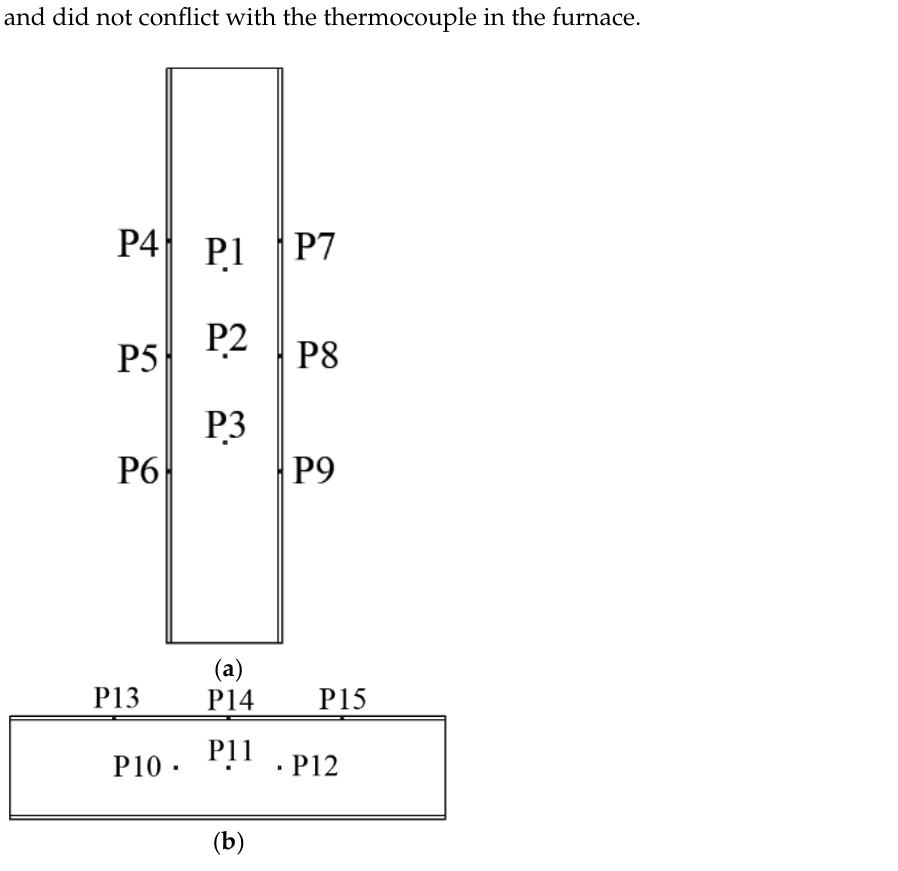
Figure 8. Temperature measuring points in the fire resistance test of the H-shaped steel ( a ) column and ( b ) beam. and ( b )